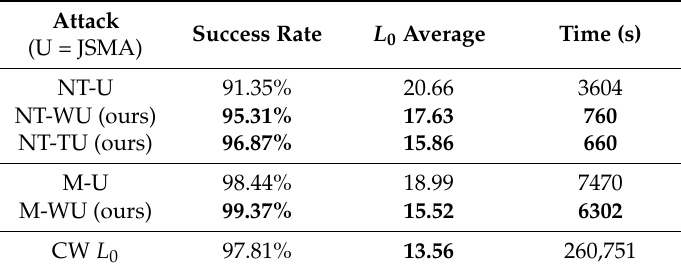
Table 6. Comparison of the performances between the NT attacks over the 1000 first test images of